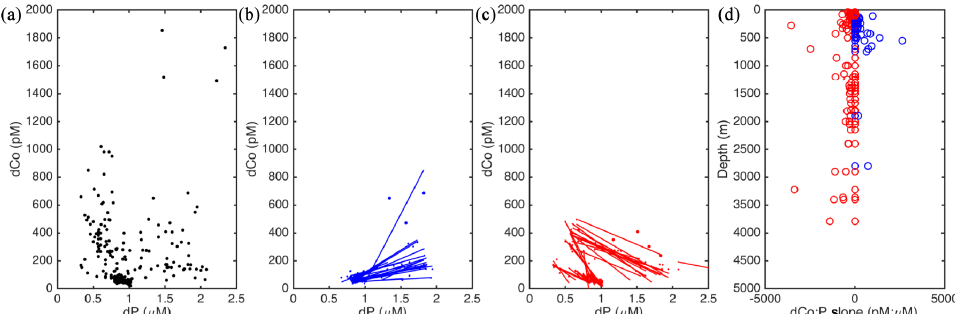
Figure 13. (a) The dCo (pmolL − 1 ) compared to phosphate (dP; µmolL − 1 ) from the GN01 dataset. (b) five-point two-way linear regression of positive dCo:P slopes ( r 2 > 0 . 6). (c) five-point two-way linear regression of negative dCo:P slopes ( r 2 < − 0 . 6). (d) Depths where either a positive (blue) or a negative (red) dCo:P slope was identified in the GN01 dataset. Additional details on the regression analysis can be found in Saito et al.